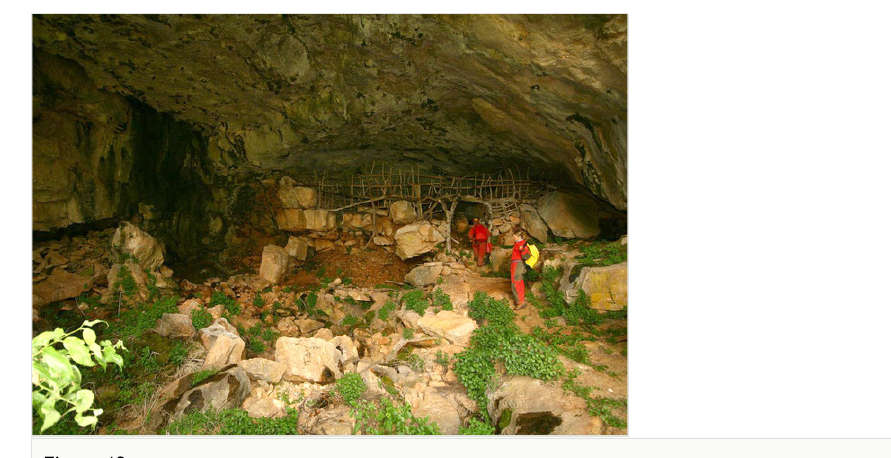
Figure 13. Entrance of cave Miljacka II, type locality of Eupolybothrus cavernicolus Komerički &